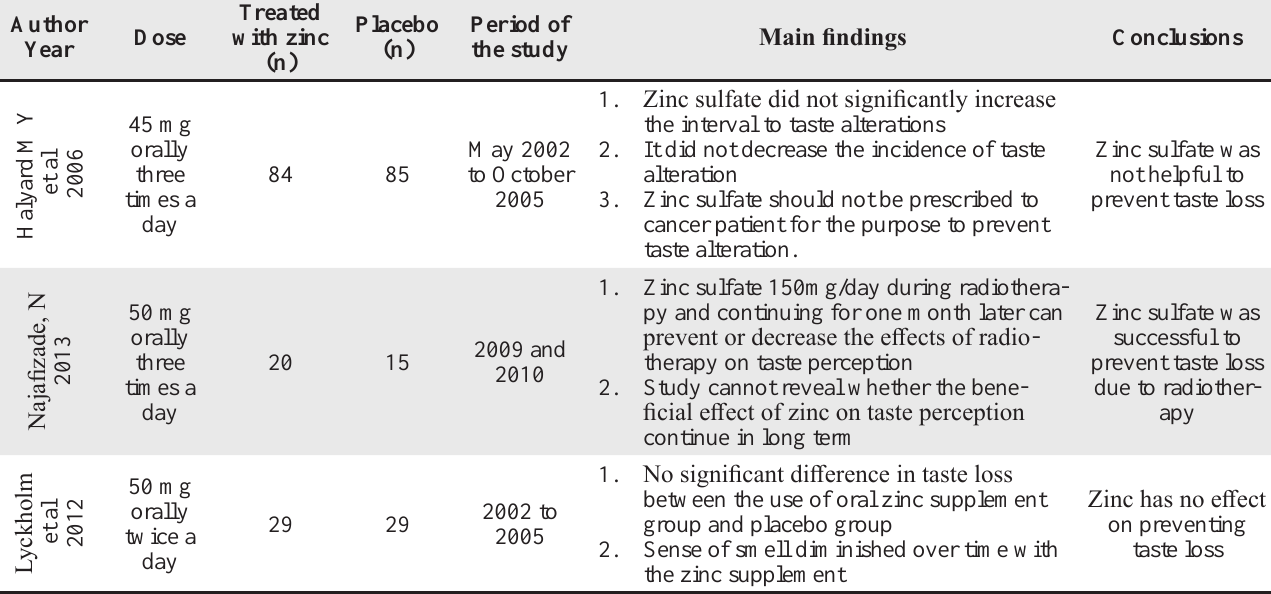
Table 3 : Summary of studies investigating use of zinc to prevent taste alteration related to cancer and its